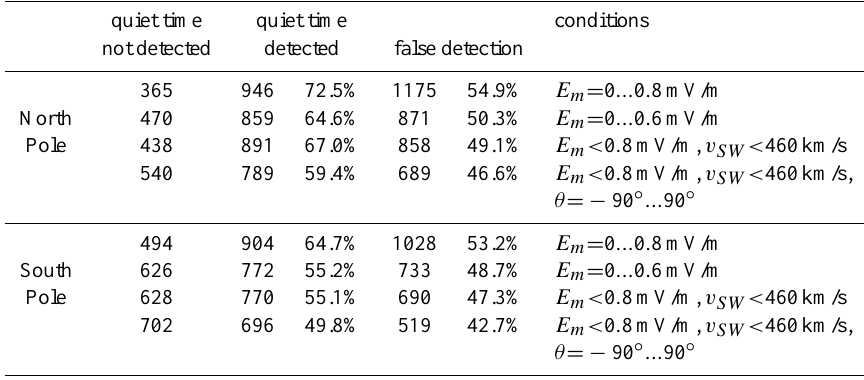
Table 2. Quiet period detection yield for various solar wind